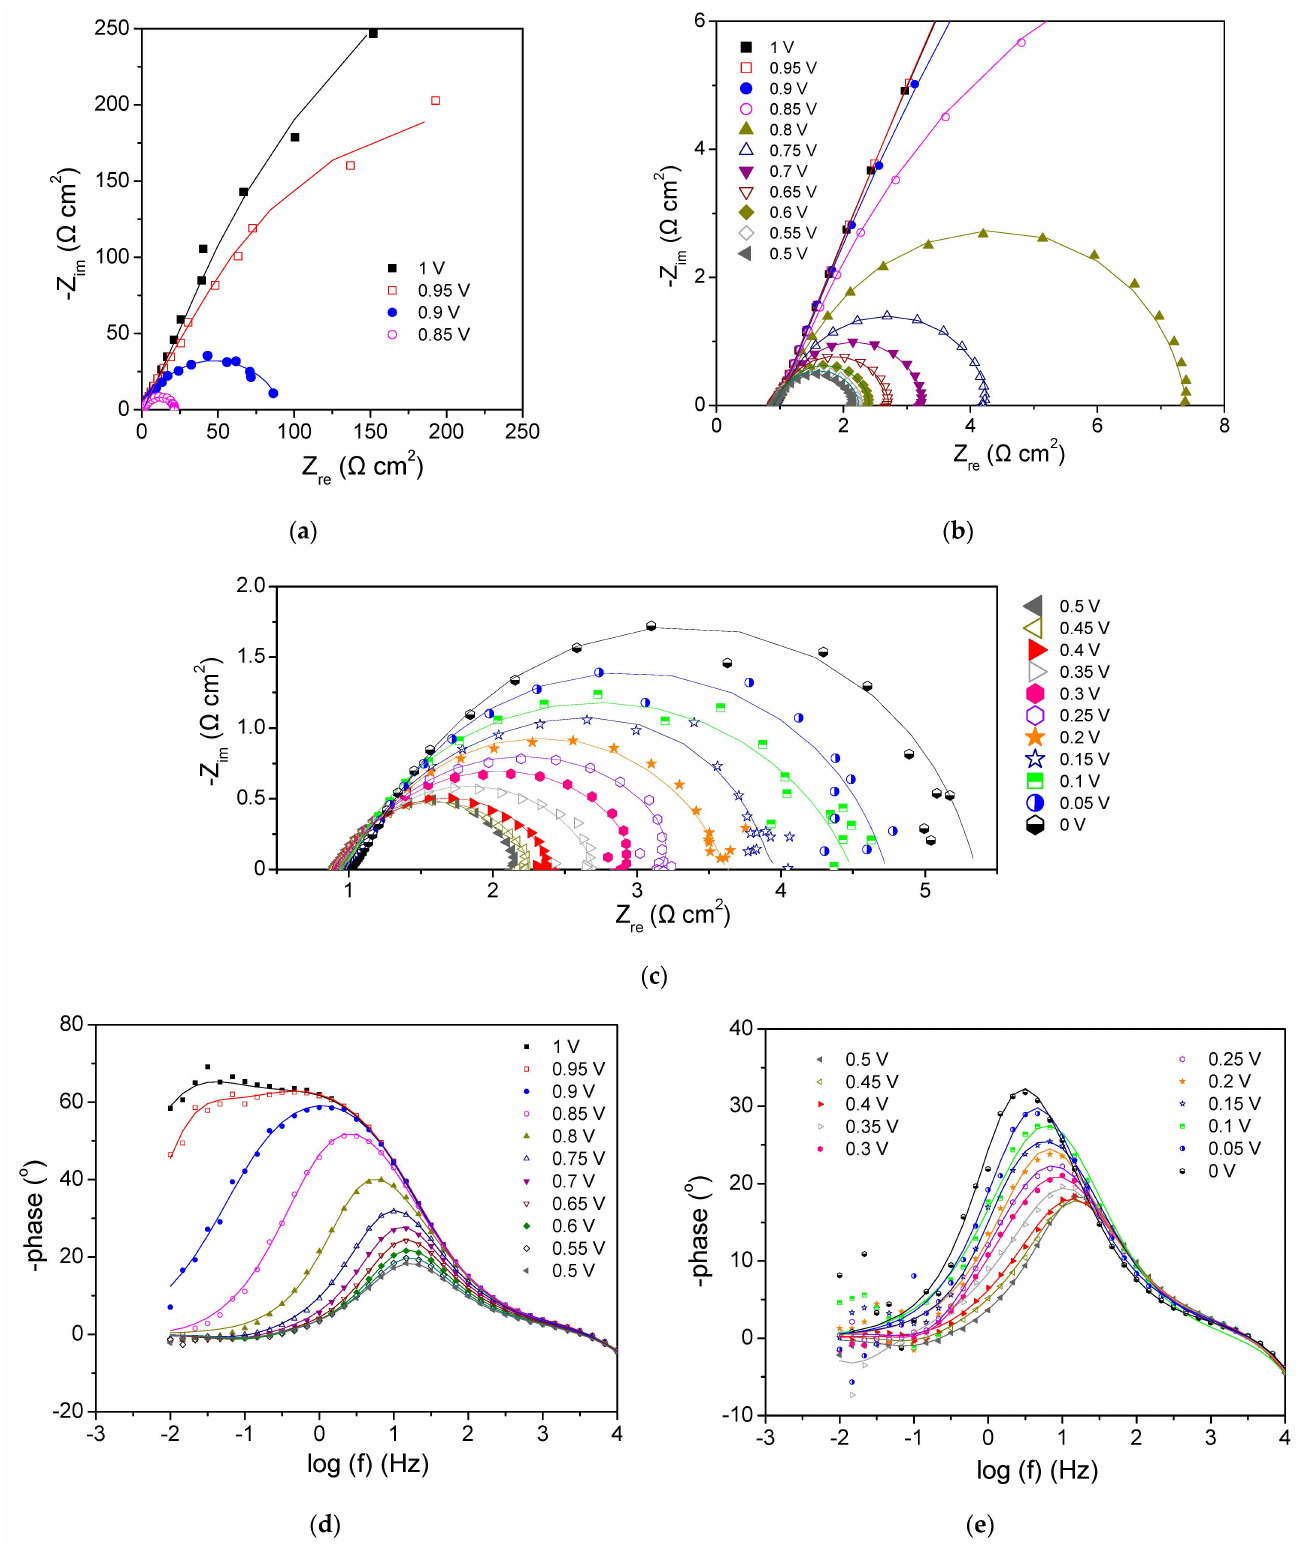
Figure 3. Effect of cell potential U fc on the EIS characteristics of the PEMFC with the 29Pt cathode electrode, presented in the form of Nyquist plots ( a – c ) and negative phase angle vs. log(frequency f ) Bode plots ( d , e ); Flow rates: F anode (100% H 2 ) = F cathode (synthetic air) = 100 cm 3 min − 1 ; geometric electrode surface area, A elec = 5.29 cm 2